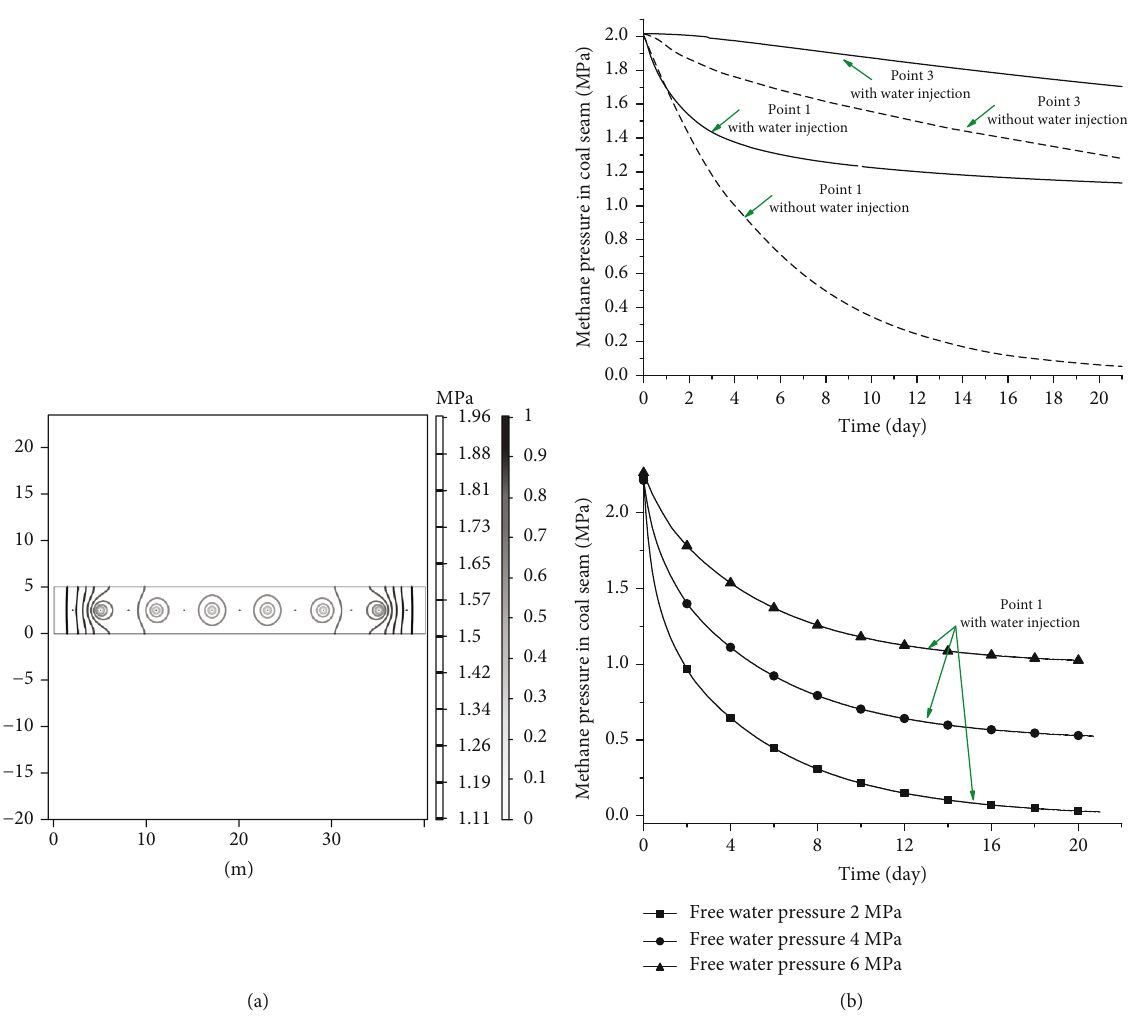
Figure 12: Fluid pressure change with time ((a) free water pressure and plastic failure zone distribution; (b) the in fl uence of free water on methane